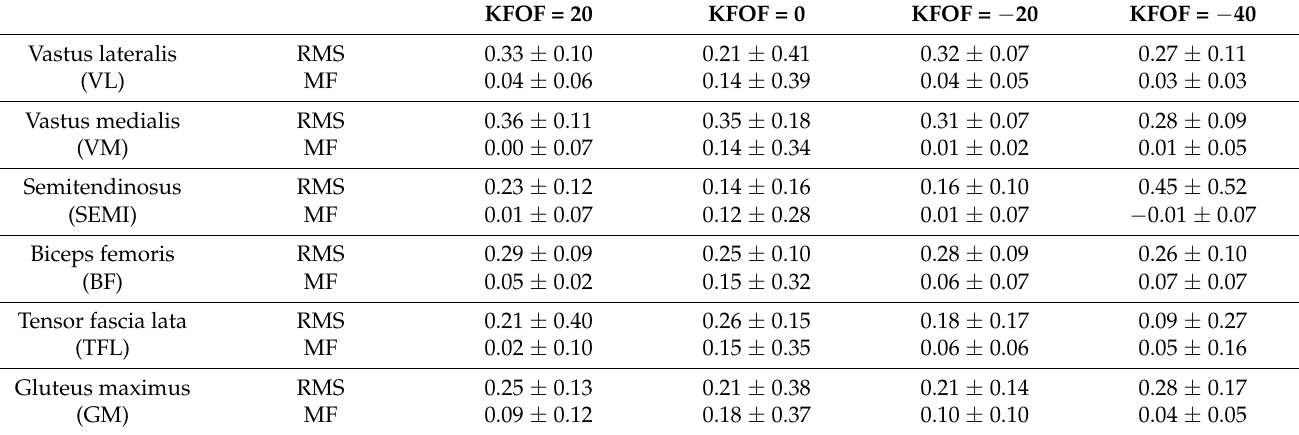
Table 2. The coefficients (mean ± SD) in the regression lines of the normalized root-mean-square (RMS) amplitude (%MVC) and median frequency (MF) of the eight muscles, heart rate, and oxygen consumption (VO 2 ) during the graded exercise test